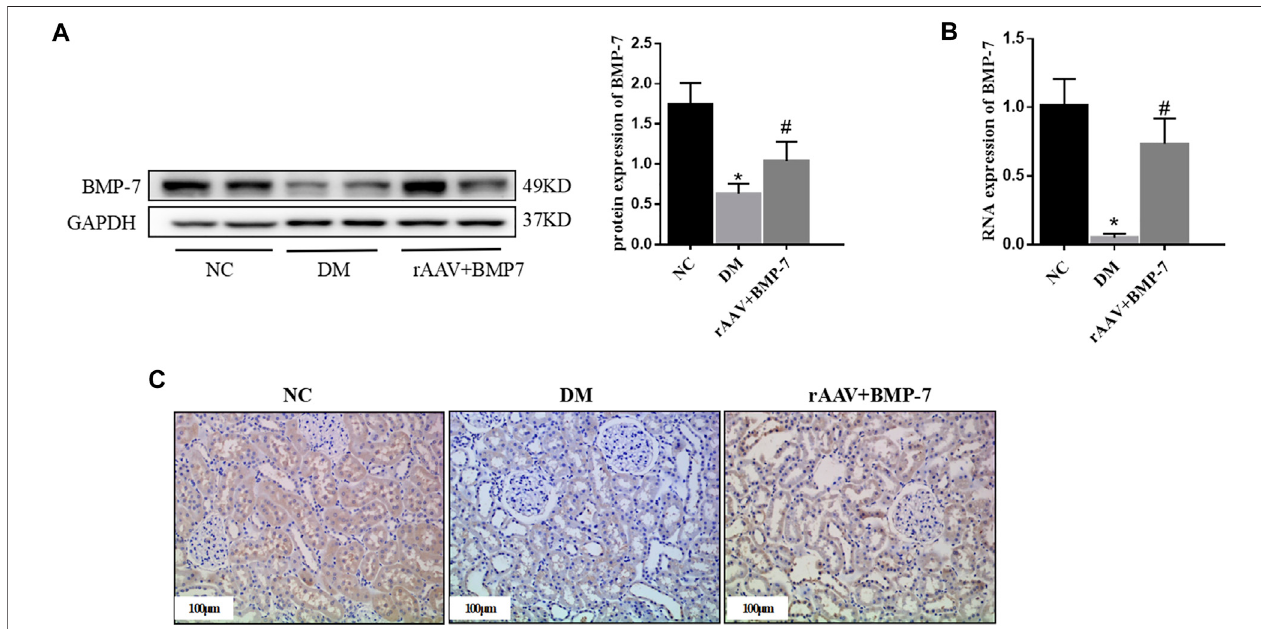
FIGURE3| ToverifythechangesofBMP-7intissueafteroverexpressionofBMP-7 invivo . (A) WesternblotwasusedtodetectBMP-7proteinexpressionlevelsin the normal control group, diabetes model group, and rAAV + BMP-7 group. (B) Real-time PCR was used to detect tissue BMP-7 RNA expression levels. * p < 0.05 vs. NC group, # p < 0.05vs.DM group. (C) Immunohistochemistry wasusedtodetect theexpression ofBMP-7intheparaf fi nsections ofkidneytissue inthenormal control group, the diabetes model group, and the rAAV + BMP-7 group (scale bar is 100 μ